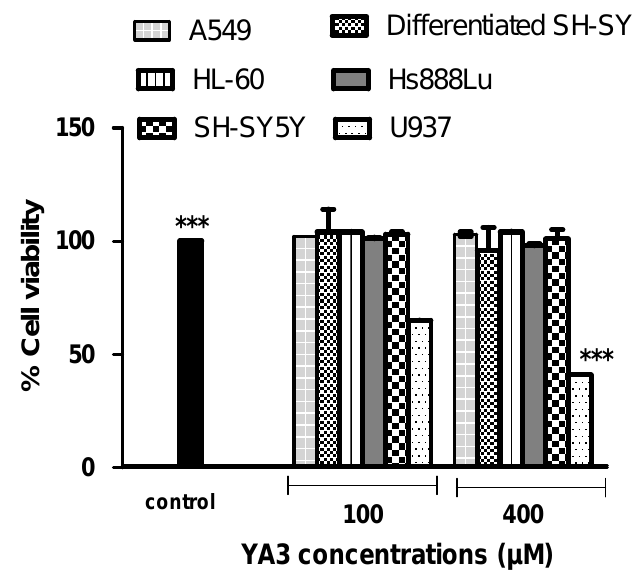
Figure 4. The response of normal and tumour cell lines exposed to spiroisozaxoline type compound YA3 for 24 h. Values are means ± SD (n = 3), all comparisons were made using two- tailed Student's t -test ( * p < 0.05, ** p < 0.01, *** p <